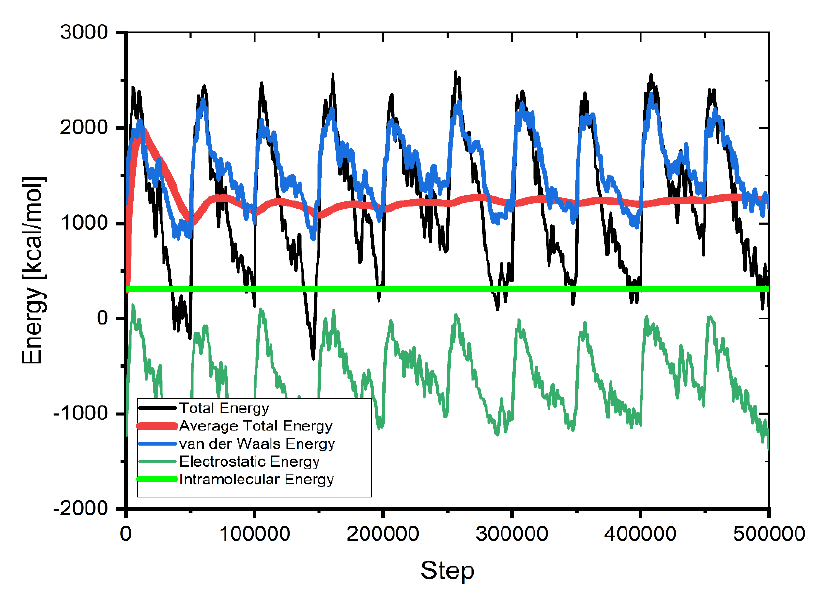
Figure 9. The contribution of the different energy terms during the MC calculations.